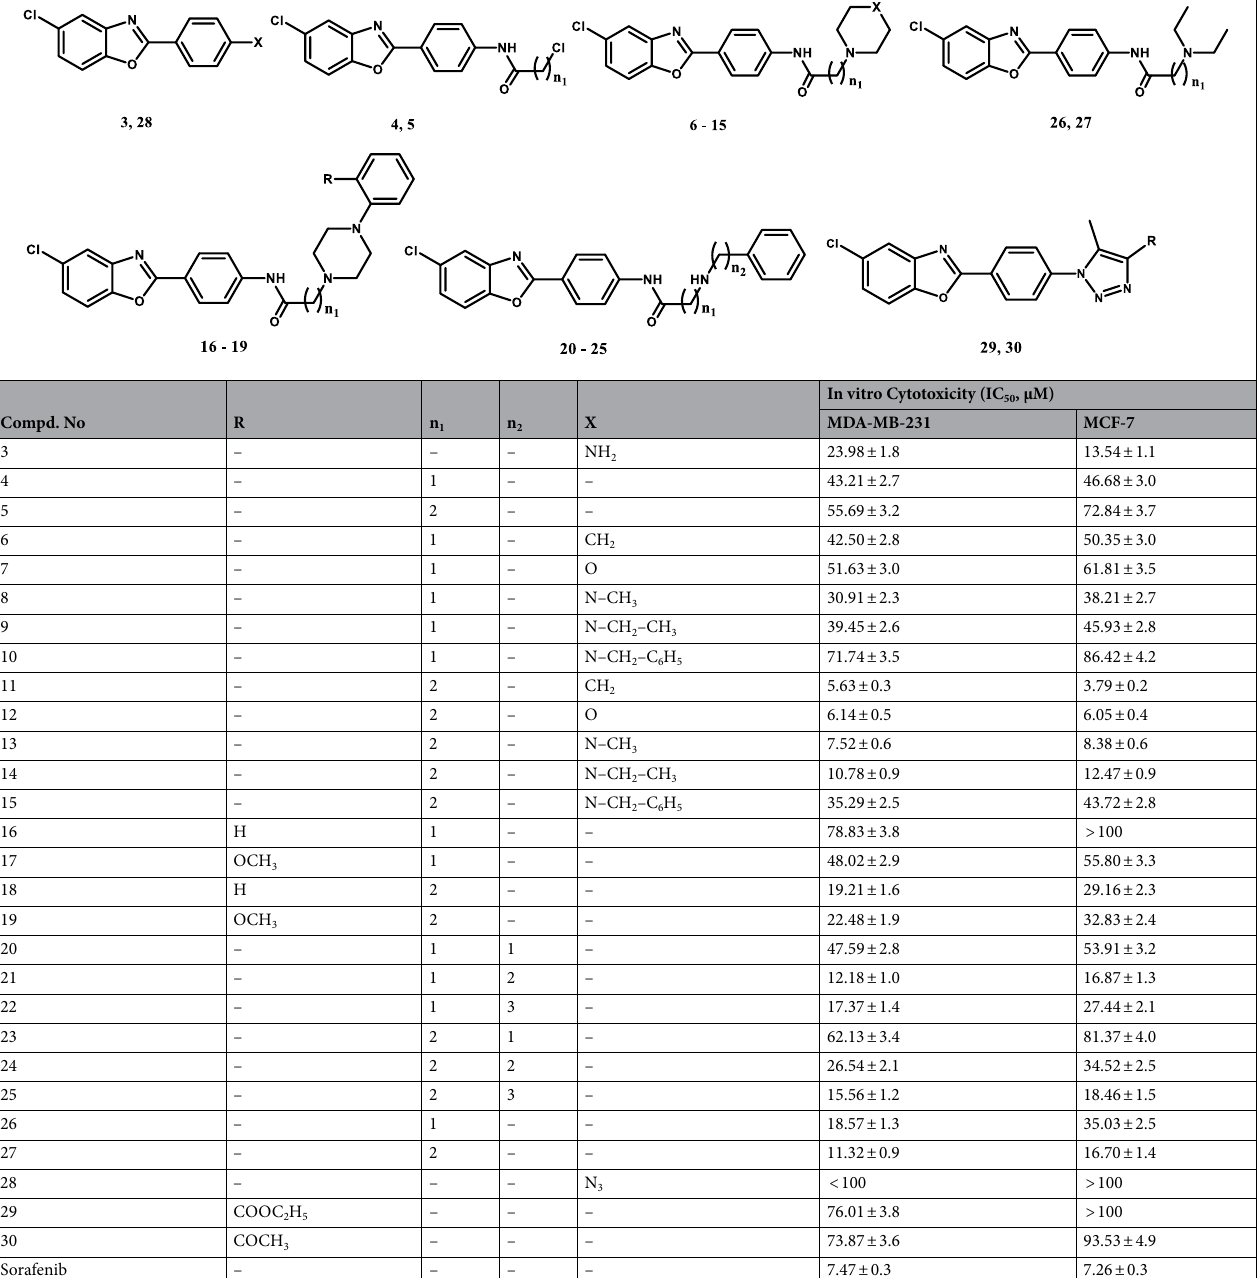
Table 1. IC 50 values of compounds 3–30 against MDA-MB-231 and MCF-7 cell lines in (µM). Significant values are in